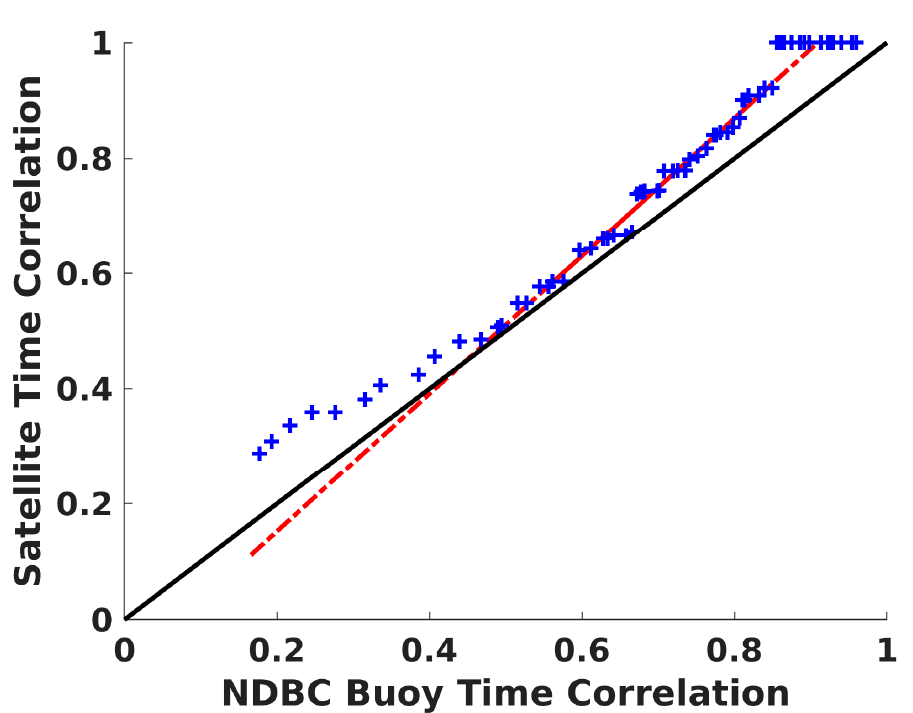
Figure A2. Comparison, illustrated through QQplot result, between temporal correlation estimated from NDBC buoy wind measurements and from homogenized remotely sensed wind